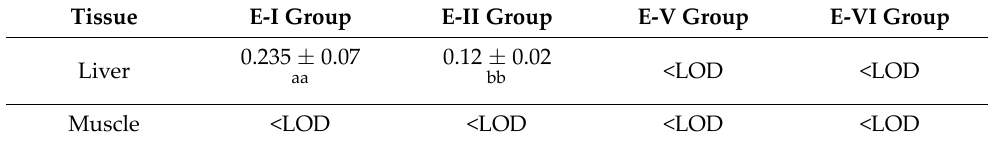
Table 10. Concentrations of AFB1 toxin and their metabolites in broiler tissues in groups fed diets with the addition of AFB1 alone or simultaneously with T‑2